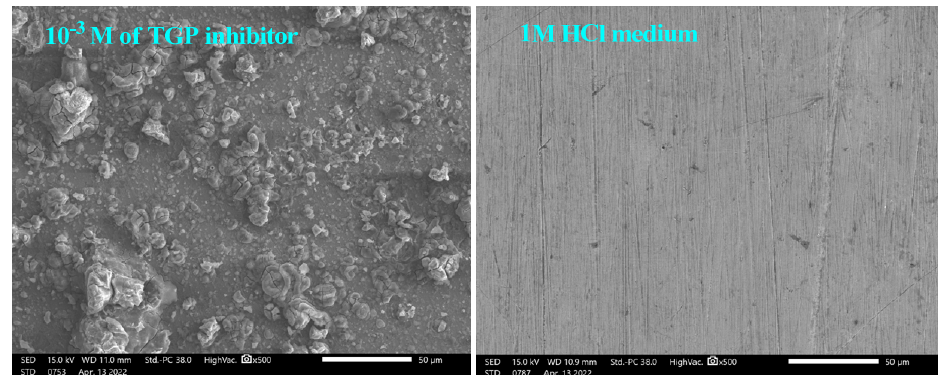
Figure 5. SEM images for MS surface plunged in 1 M HCl medium for both unprotected and protected by 10 − 3 M of TGP.